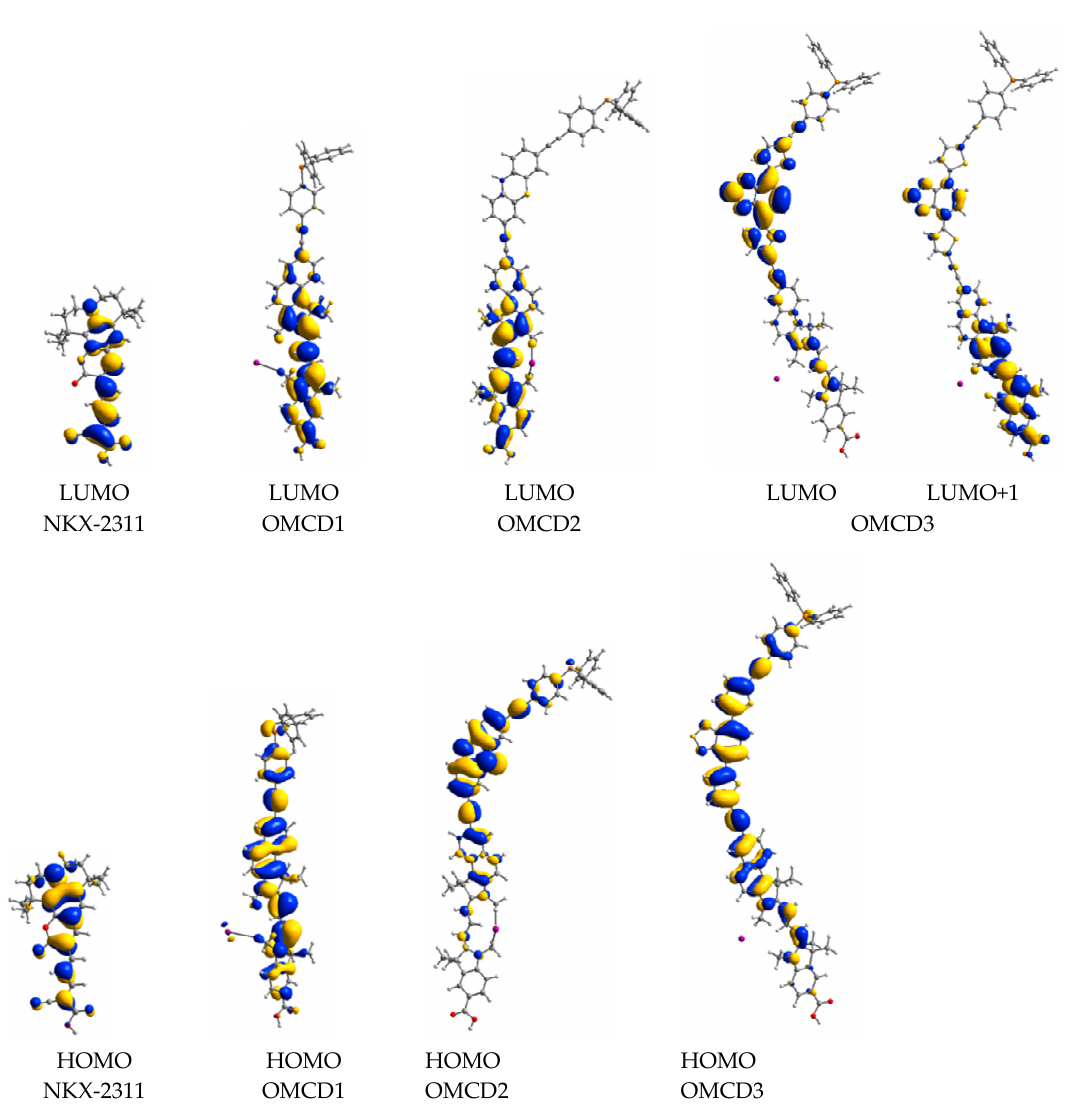
Figure 4. Isodensity surfaces (0.03 e / bohr 3 ) of the key molecular orbitals of the isolated dyes, calculated Figure 4 . Isodensity surfaces (0.03 e/bohr 3 ) of the key molecular orbitals of the isolated dyes, at the DFT / B3LYP / DZVP level in calculated at the DFT/B3LYP/DZVP level in ethanol.